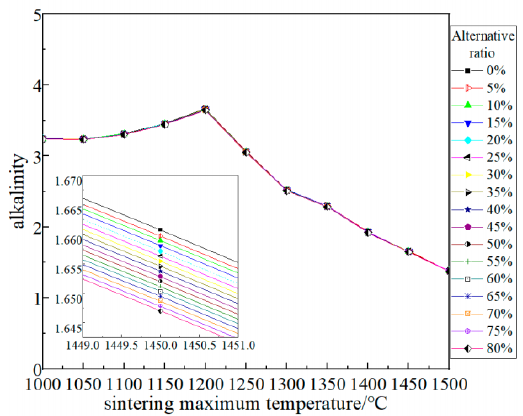
Figure 2. Change of basicity in the case of straw charcoal